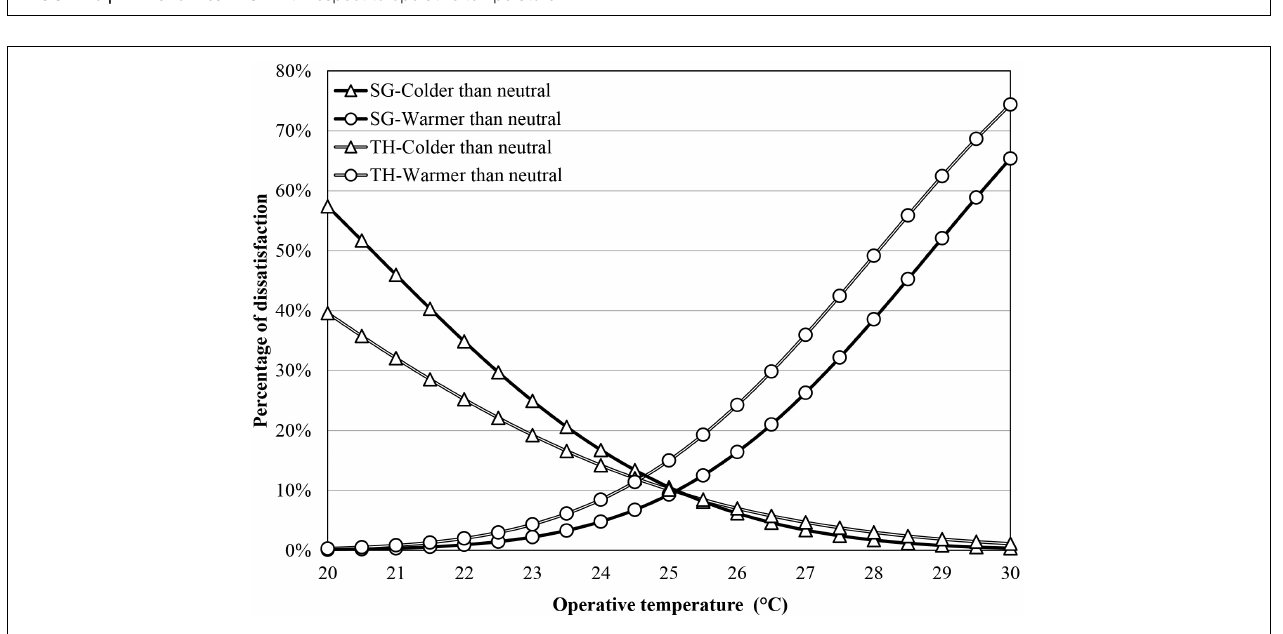
FIGURE 6 | PMV and mean TSV with respect to operative temperature.